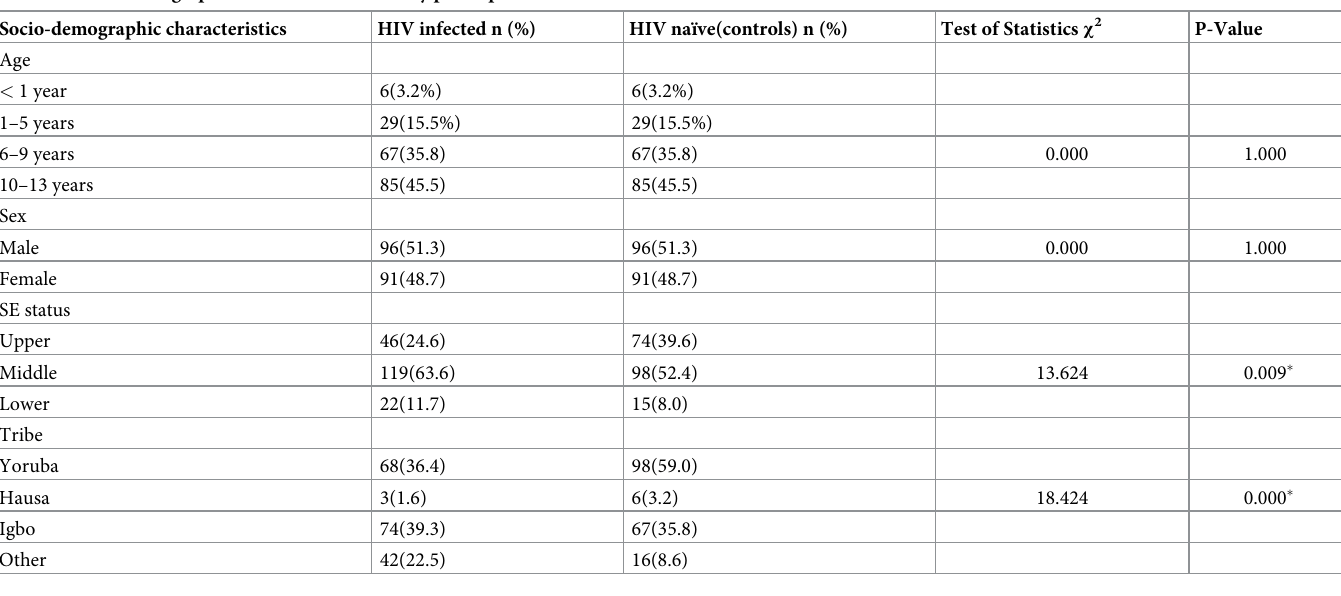
Table 1. Socio-demographic characteristics of study participants. Socio-demographic characteristics